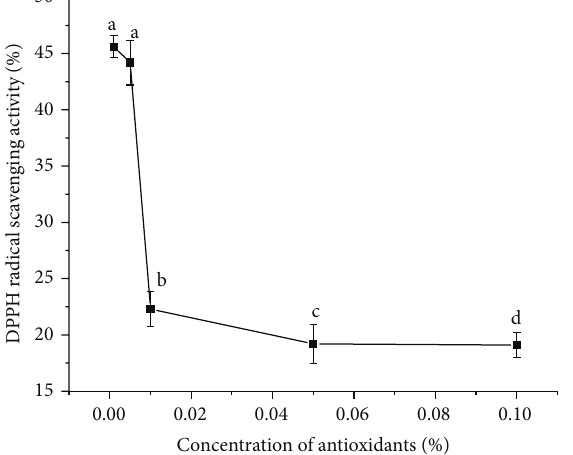
Figure 3: DPPH radical scavenging activity for 𝛼 - and 𝛽 -carotene crystals at different concentrations. Values are Mean ± SEM of 3 observations. At the 0.05 level, difference in superscripts (a, b, c, d) indicates significant difference in means.